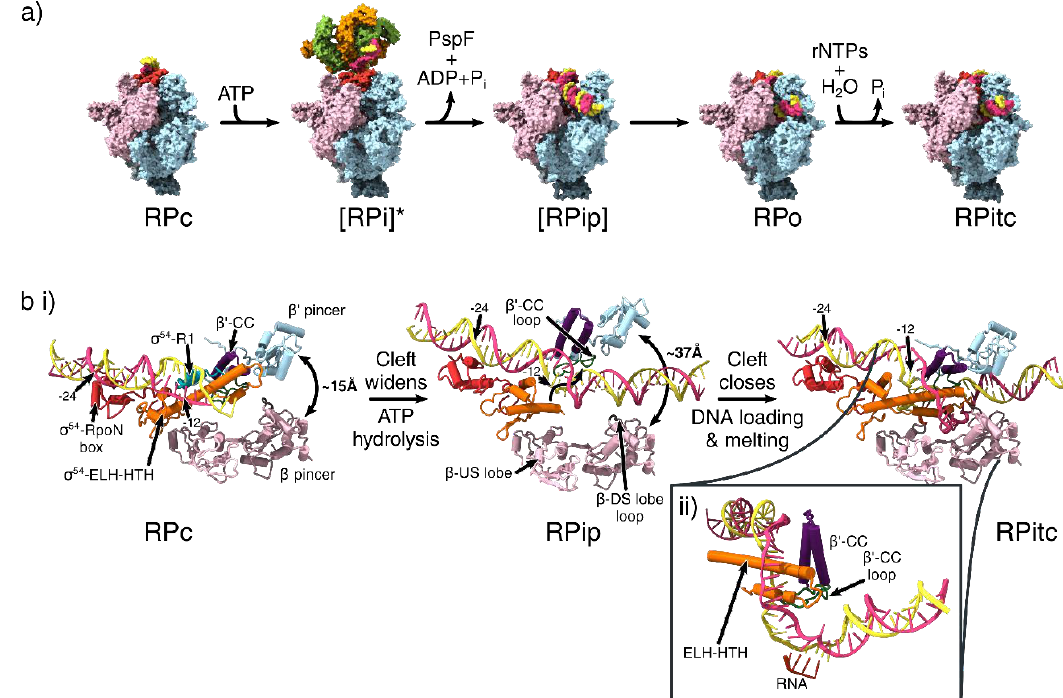
Figure 4. Conformational changes that occur during transcription initiation. ( a ) The overall structures the different functional states of transcription initiation. View is from the downstream face. Colouring is identical to that of Figure 1b for β , β ’, σ 54 and α subunits and Figure 3c for PspF. [] = Transient intermediate. * = indicates the use of ADP.AlFx to capture the transient intermediate state. ( b ) DNA melting and clamp widening during initiation. Birds-eye view of cleft, looking down into the cleft, showing only the pincers, σ 54 region I and III and DNA. The σ 54 - RpoN box is shown in red. σ 54 Region I is not resolved in RPip and RPitc models. β -DS lobe loop shown in brown, β ’-CC in purple and β ’-CC loop in green. (ii) Side view of the transcription bubble in the RPitc structure. RNA shown in dark orange. (PDB IDs: 5NSR (RPc), 5NSS (RPi), 6GH6 (RPip), 6GH5 (RPo), 6GFW (RPitc)).